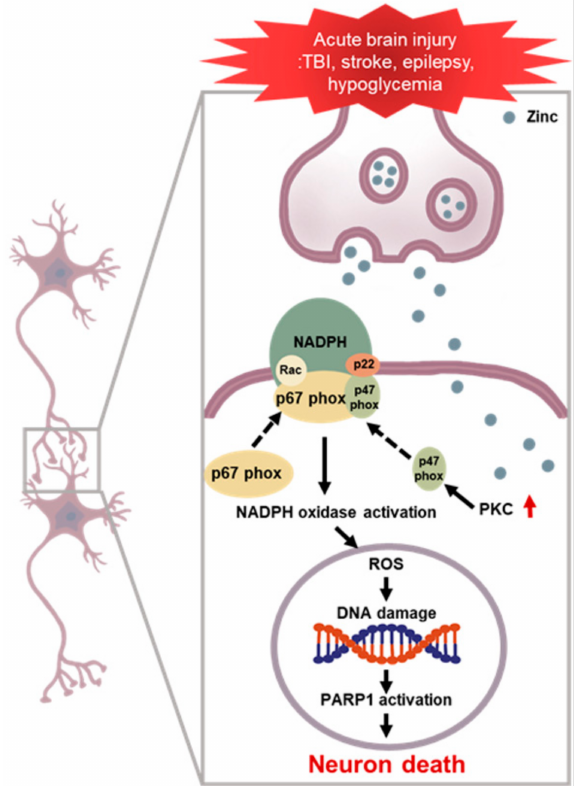
Figure 1. NADPH oxidase induced neuronal death after brain injury. Multiple acute neurological disorders lead to zinc release from the presynaptic neurons and translocation into the postsynaptic neurons, which, in turn, activates neuronal NOX. The p47phox component is phosphorylated and migrates to the plasma membrane, where it binds with other subunits to form an active enzyme complex. Activated NOX produces ROS, which is released into the intracellular or extracellular space and contributes to progressive DNA damage. ROS produced by NOX lead to further accumulation of zinc in the postsynaptic neurons, aggravating the cascades. PARP 1 is excessively activated due to DNA damage and leads to energy failure and mitochondrial dysfunction. This devastating cascade eventually leads to neuronal